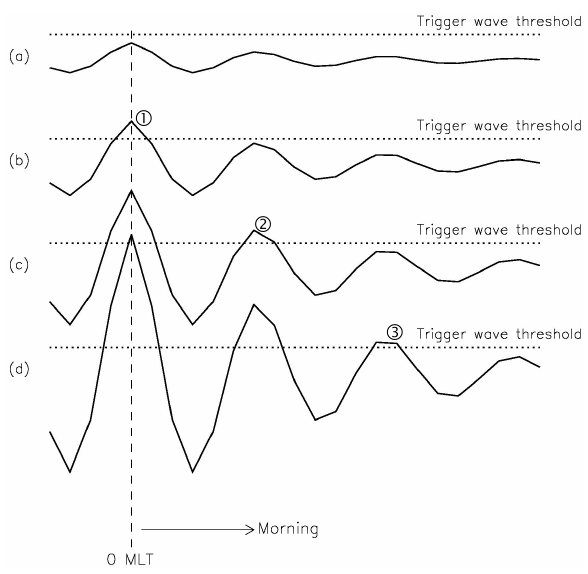
Fig. 13. A schematic diagram explaining the successive appearance of discrete auroral patches, which correspond to a series of “trigger waves” in the NGOPS.